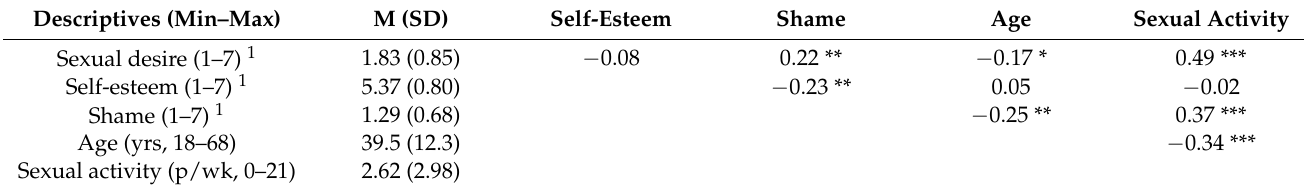
Table 1. Means and standard deviations of the total sample, as well as the correlations between the descriptive